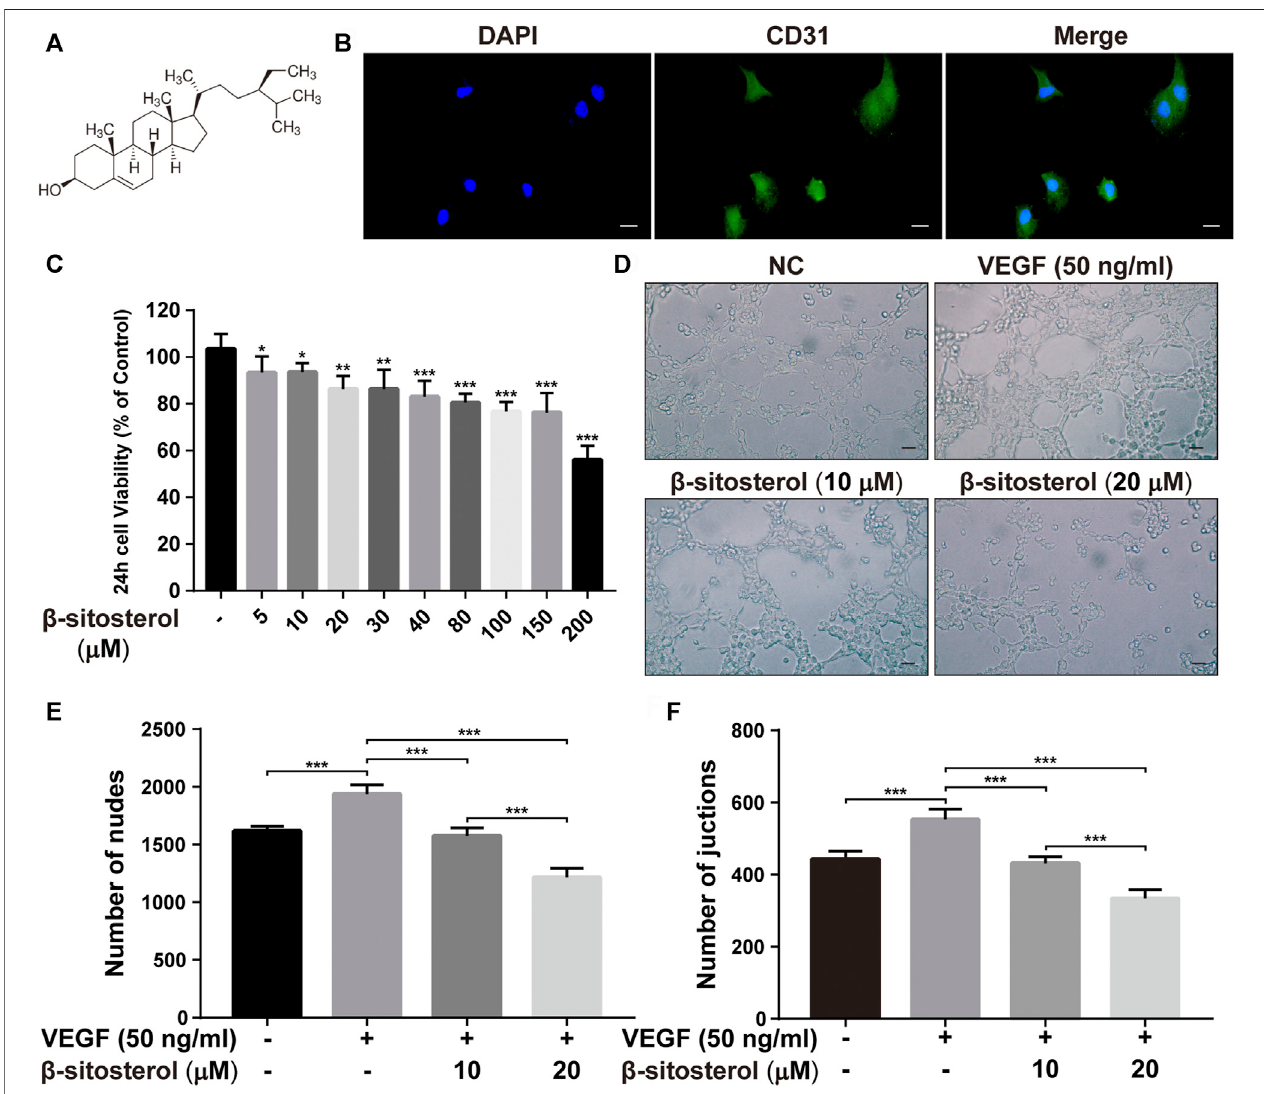
FIGURE 1 | BSS inhibits angiogenesis in HUVECs. (A) BSS chemical formula (quoted from sigma of fi cial website). (B) CD31 fl uorescent staining identi fi cation (×630, scale bar = 20 μ m). (C) Effects of different concentrations of BSS on CCK-8 in HUVECs after 24 h ( n = 3). (D) Representative images of tube formation at 6 h in HUVECs (×200, scale bar = 50 μ m), Y -axis shows the nodes (E) and junction numbers (F) ( n = 3). All data are shown as the mean ± SEM. * p < 0.05, ** p < 0.01, *** p < 0.001.